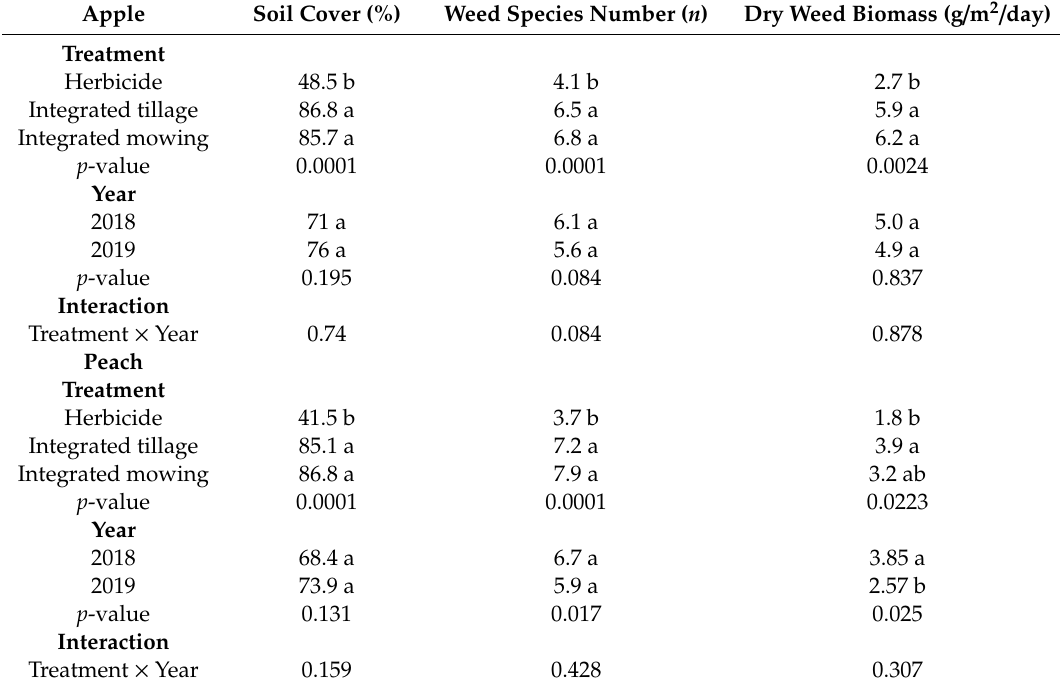
Table 3. E ff ects of integrated weed control methods, year and their interactions on apple and peach orchard biodiversity variables.